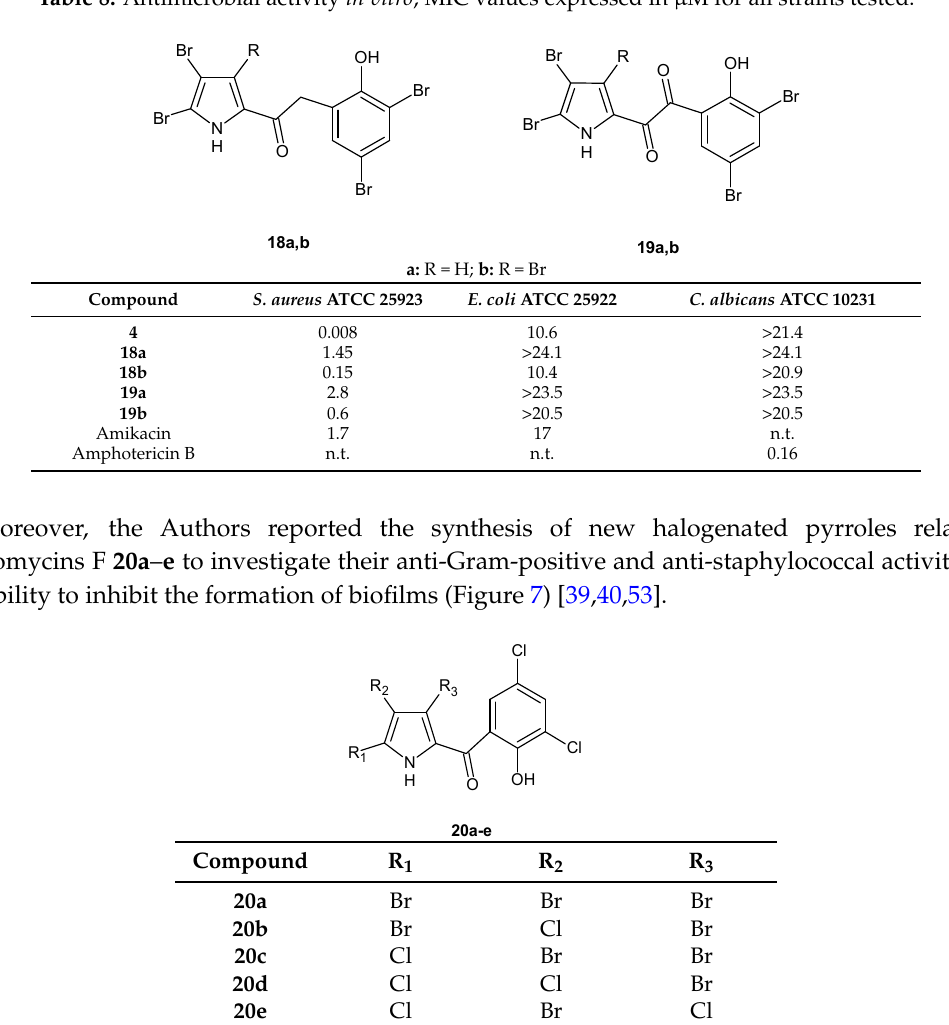
Figure 7. Structures of compounds 20a – e .